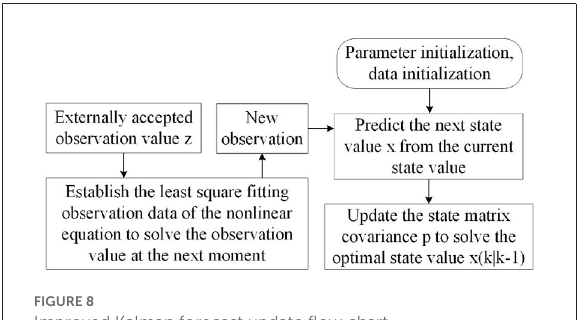
FIGURE8 Improved Kalman forecast update flow